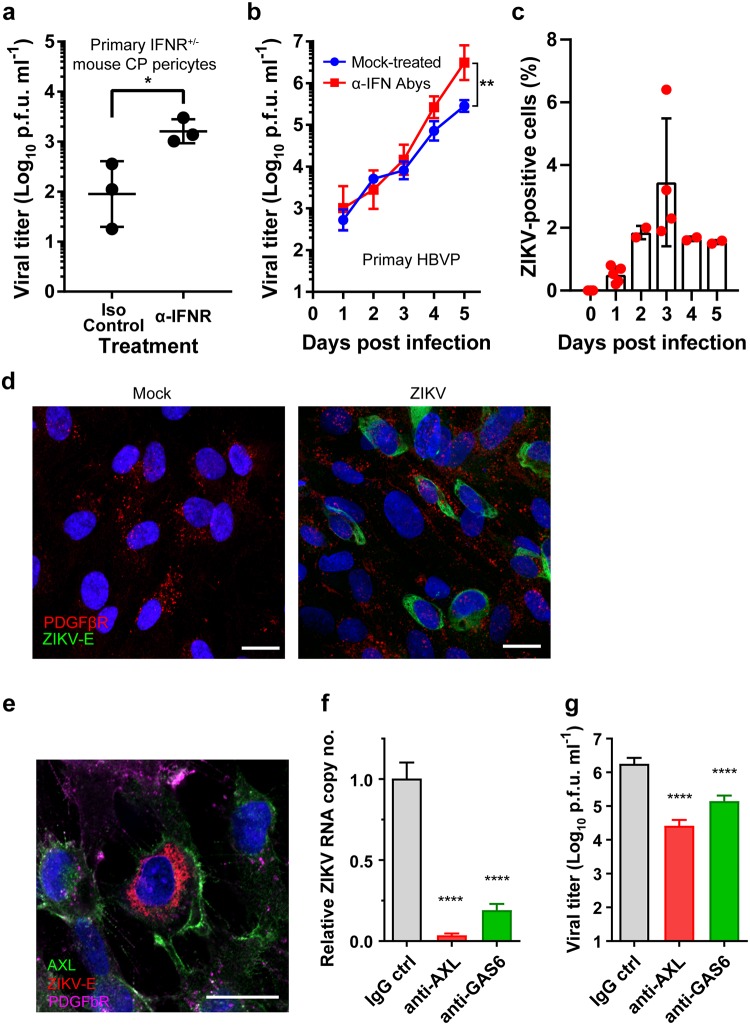
ZIKV infects human brain vascular pericytes in an AXL-dependent manner.a, ZIKV replication in primary pericytes from mouse choroid plexus (IFNAR+/-). Cells (three independent wells) were infected with ZIKV, PLCal_ZV (MOI = 0.1) and grown in the presence of 5 μg/mL mouse anti-IFNAR-1 neutralizing antibody (clone MAR 5A3, ɑ-IFNAR) or isotype control antibody (clone MOPC-21). The cell culture supernatant was harvested at 5 DPI, and the virus titer was enumerated. * P <0.05 (Student’s t-test) b, Primary human brain vascular pericytes (five independent wells) were infected with ZIKV as in a and then incubated in the presence/absence of a human type 1 IFN neutralizing antibody mixture (ɑ-IFN Aby). The supernatants were harvested every 24 hours for five days, and the virus titers were enumerated with a virus titration assay. ** P < 0.005 (two-way ANOVA). c, Primary human brain vascular pericytes were infected with ZIKV and ZIKV-infected cells were enumerated by using FACS with anti ZIKV-E (clone 4G2). Each dot represents cells from single well. d, Mock- or ZIKV-infected HBVP were stained with antibodies against PDGFβR (red) and ZIKV-E protein (green). Two consecutive confocal layers were projected into a single layer with the Z-project function of ImageJ software (version 2.0.0). e, HBVP infected with ZIKV were stained with antibodies against AXL (green), PDGFβR (magenta) and ZIKV-E protein (red). Scale bars = 20 μm. f and g, HBVP were pre-treated with antibody for three hours then infected with ZIKV (m.o.i. = 1). Three days later, viral RNA (f) and progeny virus titers in the supernatants (g) were analyzed. **** P < 0.001 (one-way ANOVA).